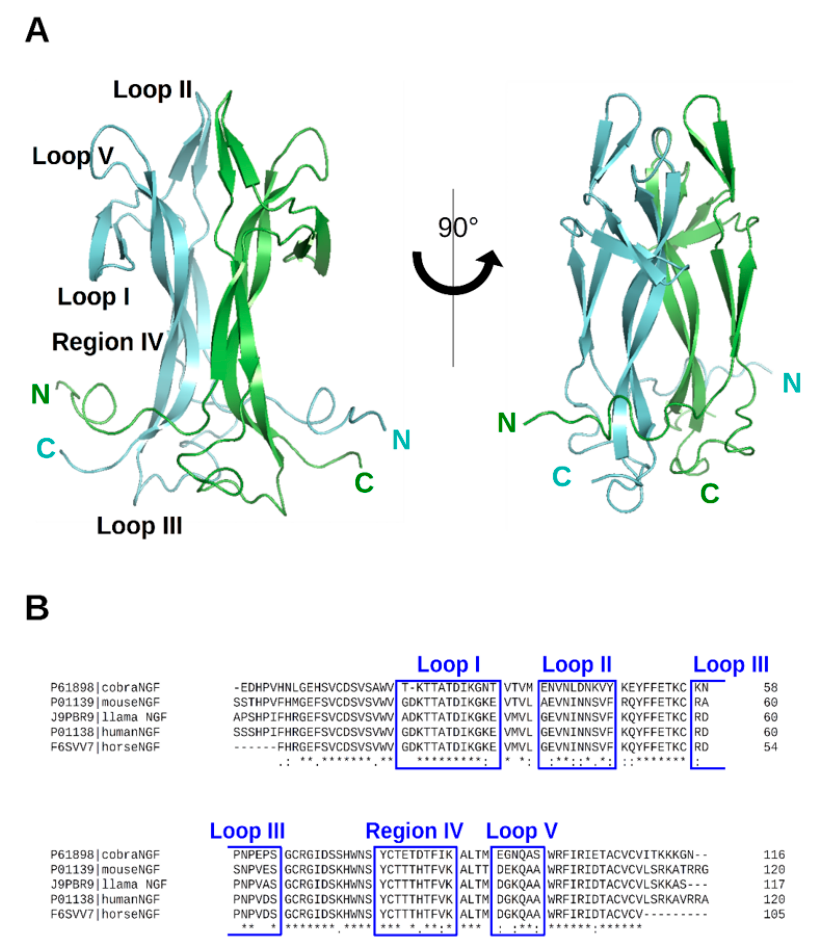
Figure 2. ( A ) 3D structure of NGF (PDB ID: 6YW8 [5]). The two protomers are colored in cyan and green, respectively. N- and C-termini are labeled. Loops have been labelled according to Ibanez [27]. Two different protein orientations are shown. Figures were produced using PyMOL [28]. ( B ) Sequence alignment of the NGF of the different species for which a PDB-deposited 3D structure is available. The alignment was performed with ClustalW webserver [29]. UniProt entry numbers are indicated. Loops have been labelled according to Ibanez